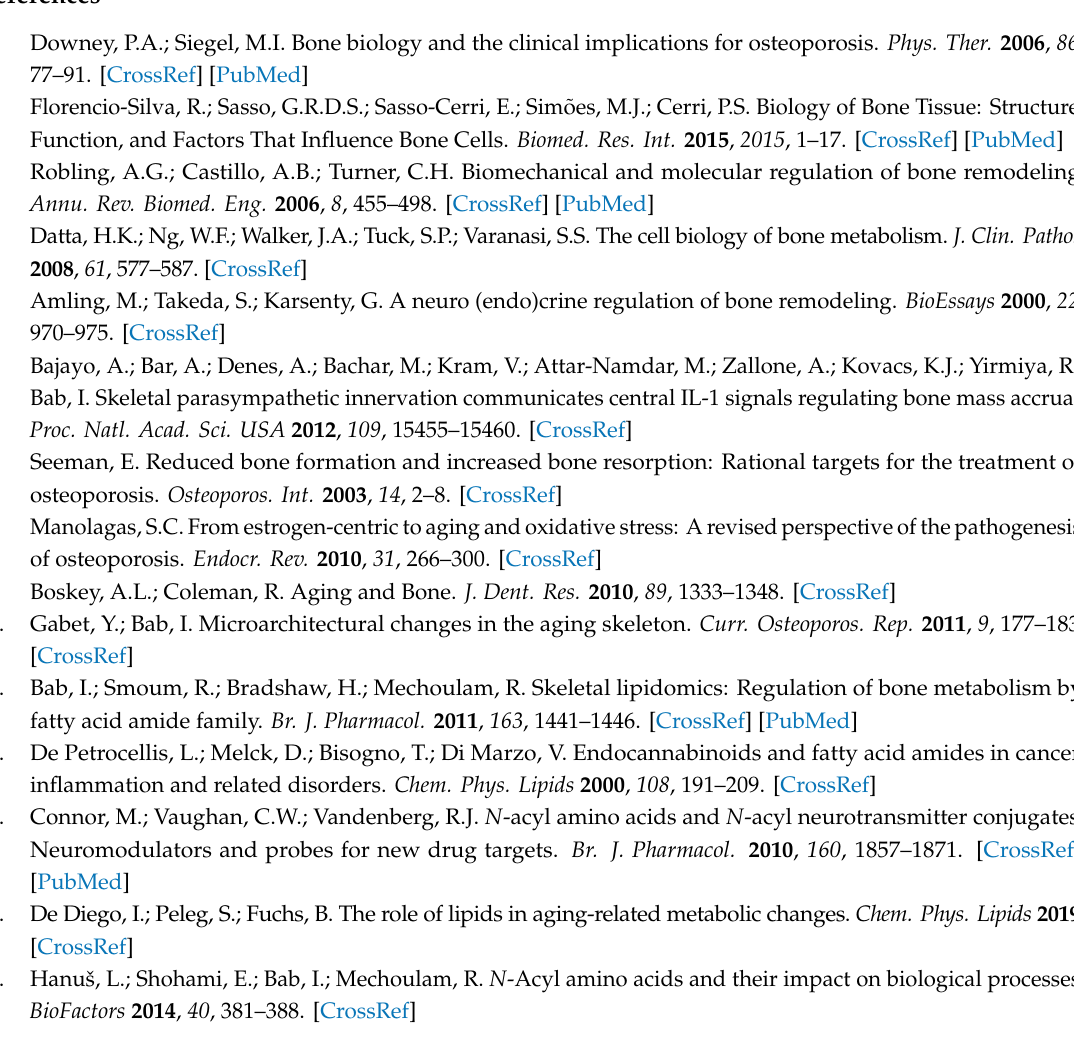
Figure A1. The e ff ect of methylated OS derivatives on cortical thickness (Cort. Th.). Data represent the Supplementary Figure 1. The effect of methylated OS derivatives on cortical thickness (Cort. Th.). mean ± SDs obtained from 7–9 mice per condition, * p < 0.05 versus the Sham-OVX / Veh-treated Data represent the mean ± SDs obtained from 7 – 9 mice per condition, * p < 0.05 versus the Sham- OVX/Veh-treated group.